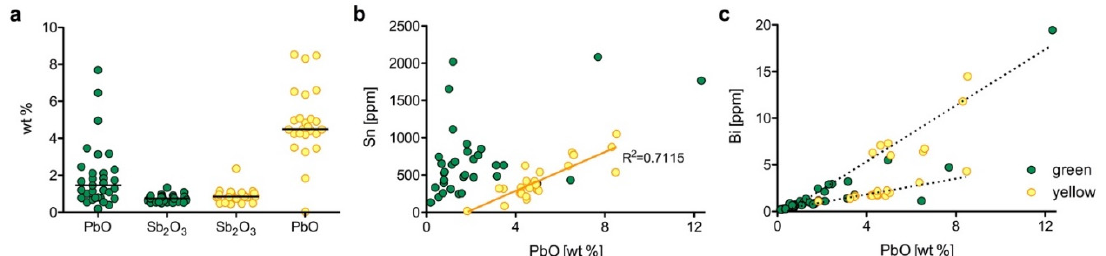
Figure 6. Lead antimony compounds responsible for the opaque green and yellow tesserae. ( a ) The concentration of lead and antimony differs between the green and yellow samples; ( b ) low concentrations of tin are positively correlated with lead in the yellow samples, indicating that tin entered the glass as an accessory element of the lead raw material; ( c ) two different correlations of lead and bismuth are apparent (indicated as dotted lines), suggesting the exploitation of different lead sources.